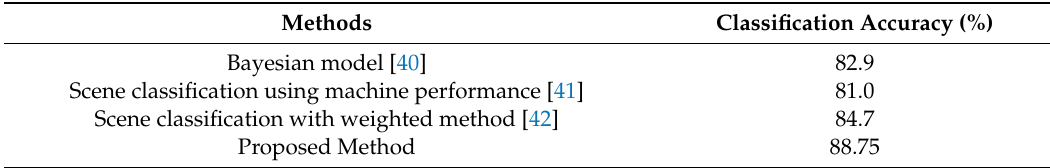
Table 5. Comparison of the proposed method with other state-of-the art methods using the MSRC